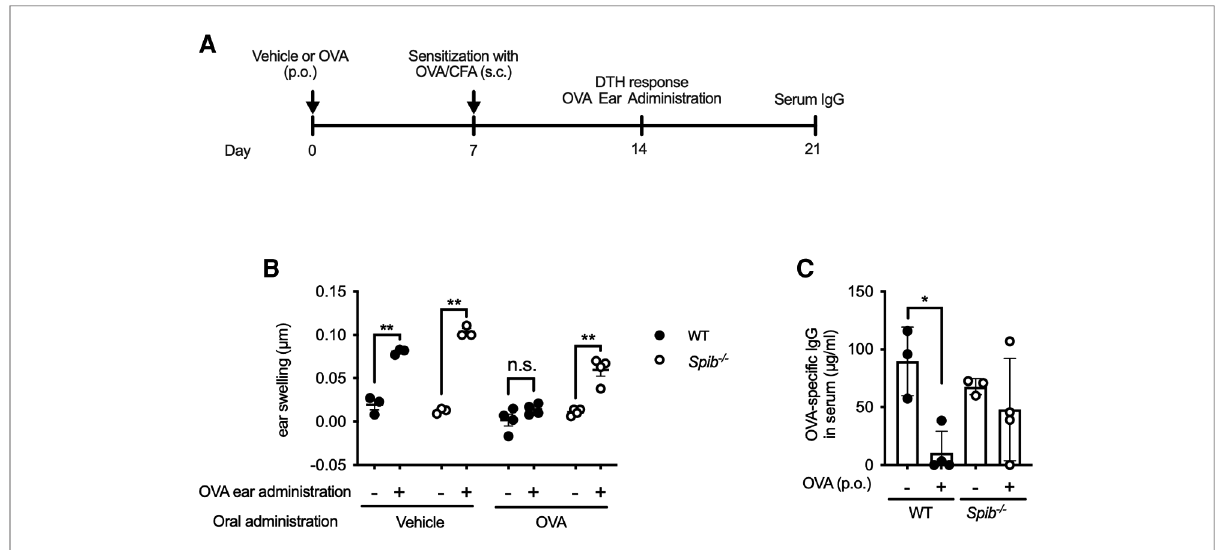
FIGURE 5 The oral tolerance is disrupted in Spib − / − mice. ( A ) The experimental design of investigating oral tolerance. ( B ) OVA/PBS or PBS were injected in the right or left ear, respectively. The ear swelling was measured to estimate DTH response. ( C ) OVA-speci fi c IgG levels in the serum were measured by ELISA. Representative data from at least two independent experiments are shown. Data are expressed as mean±SEM ( n =3 or 4). * p <0.05, ** p < 0.01, n.s.: not signi fi cant, calculated by two-way ANOVA for ( B ) and one-way ANOVA for ( C